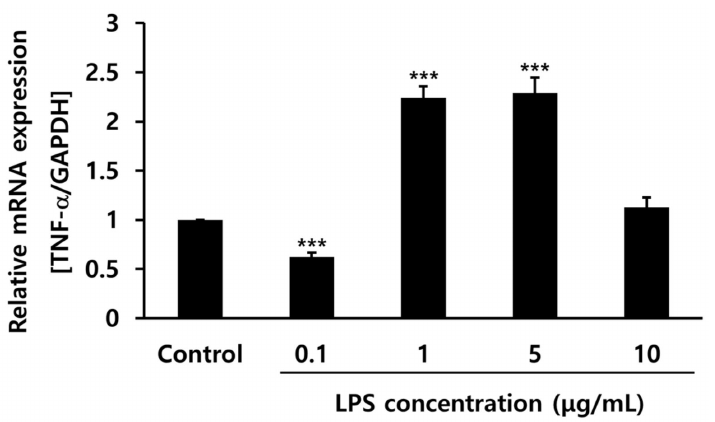
Figure 2. Tumor necrosis factor (TNF)- α gene expression levels with different concentrations of lipopolysaccharide (LPS) (0.1, 1, 5, and 10 µ g/mL) in human periodontal ligament cells. *** p < 0.001 vs.